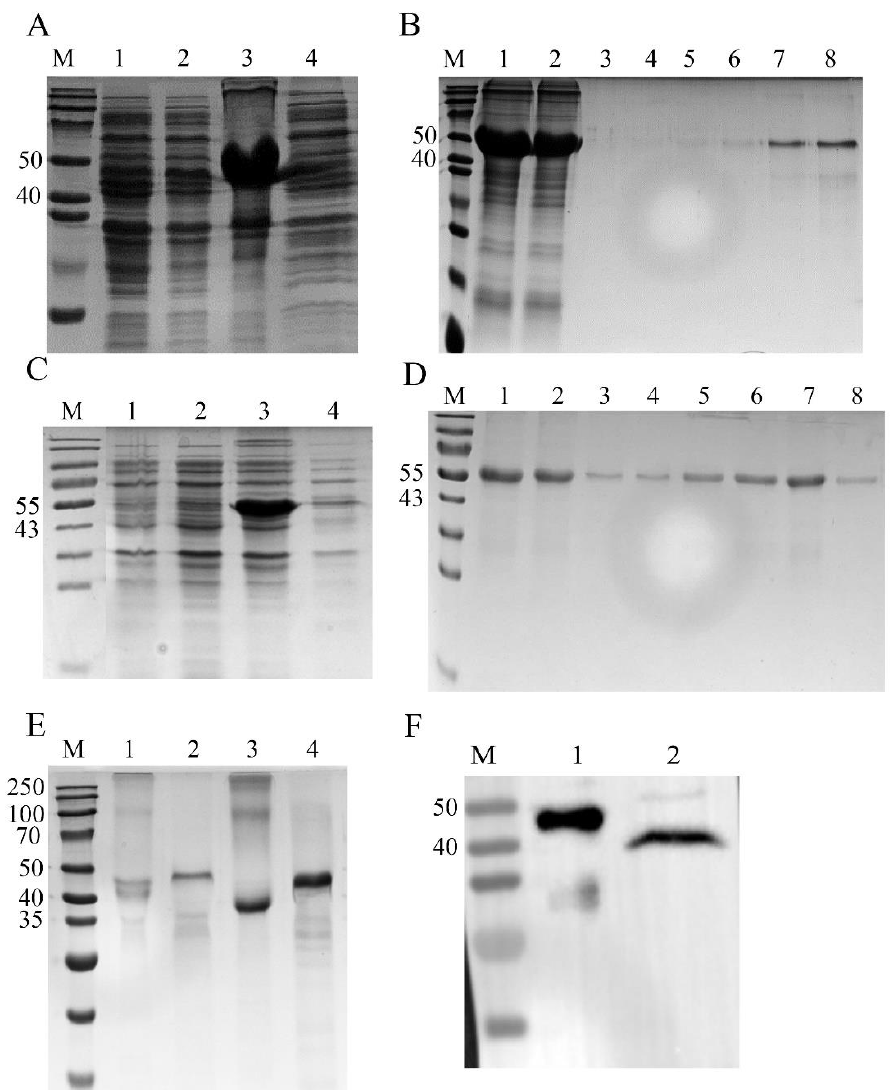
Figure 2. Prokaryotic expression and purification of rSsZPB2a, rSsZPB2c and detection of antiserum